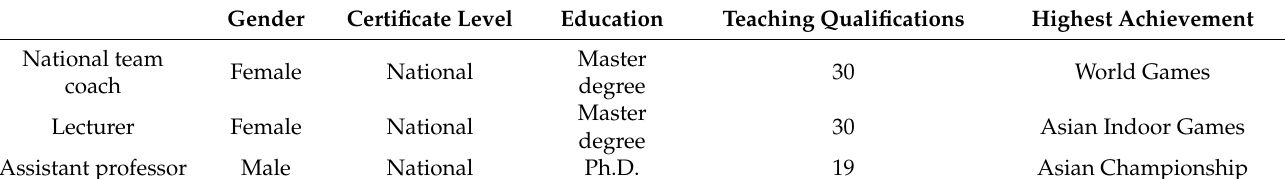
Table 1. Background of experts and